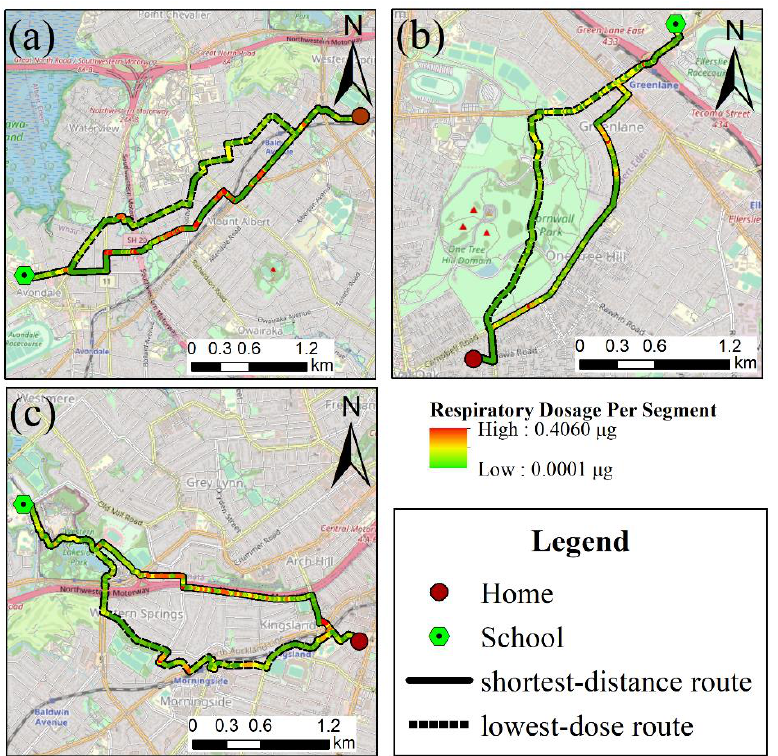
Figure 5. Examples illustrate the generation of the lowest-dose route compared with the routine shortest-distance route. ( a ) riding along a local road parallel with the major road; ( b ) using the pathway in a park or greenspace close to the major road; ( c ) using a distant less-polluted road parallel with the heavily polluted motorway.